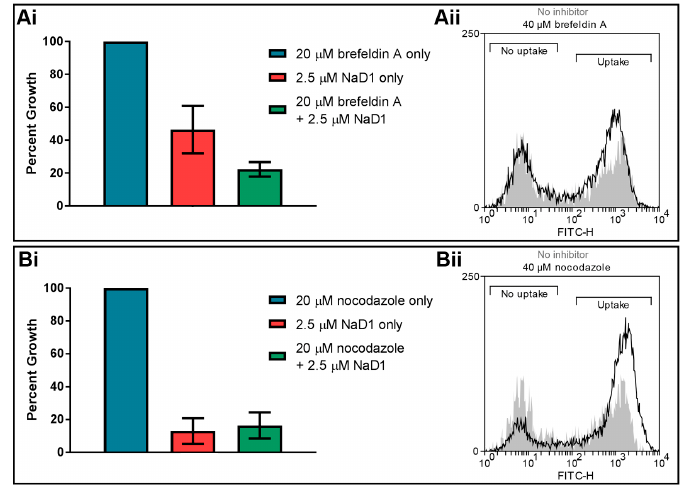
Figure 6. Brefeldin A and nocodazole do not affect the activity of NaD1 against C. albicans. C. albicans DAY185 was treated with 2.5 µM NaD1 only, inhibitors only or 2.5 µM NaD1 and ( Ai ) 20 µM brefeldin A or ( Bi ) 20 µM nocodazole in combination. Data are relative to the inhibitor only controls. Error bars represent SEM ( n = 3). No values were significantly different (using an independent t -test) to the NaD1 only control ( p -value > 0.05). C. albicans DAY185 was treated with 10 µM BODIPY-NaD1 for 15 min with ( Aii ) 40 µM brefeldin A or ( Bii ) 40 µM nocodazole. Cells with BODIPY fluorescence were counted using a flow cytometer and separated to determine the percentage of cells that had taken up the BODIPY-NaD1 in the presence (black line) and absence of inhibitors (grey shading).